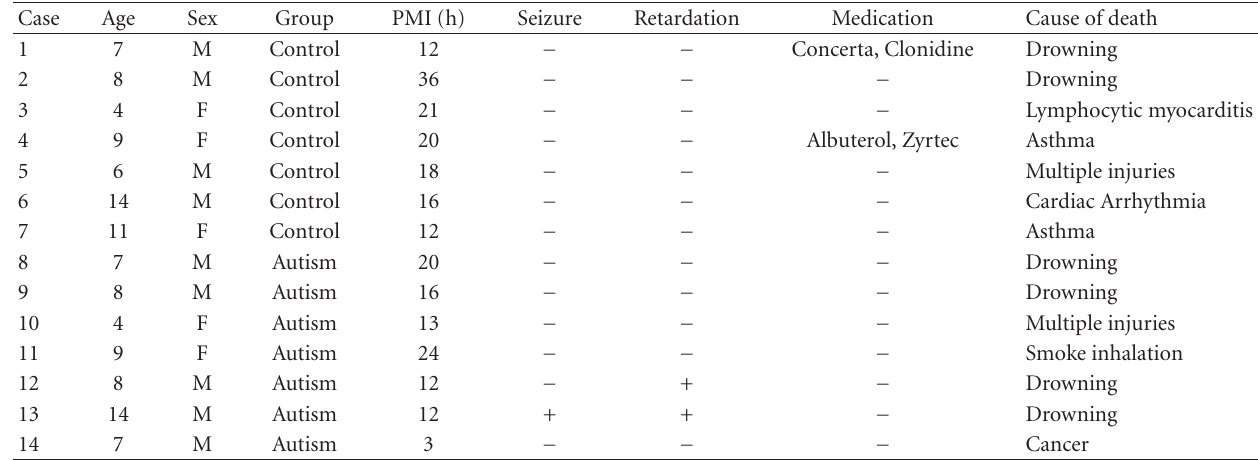
Table 1: Study subject